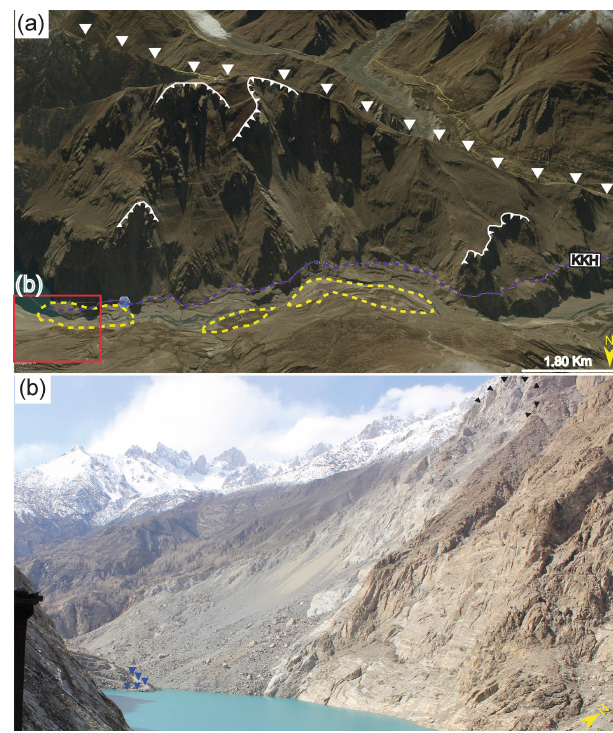
Figure 15. High landslide susceptibility along the highway in Hunza Valley (Google Earth, 2017c, Bing Maps) (for location see Box “Z” in Fig. 13b). (a) Overview of 11km long small section west of the Attabad Lake: white lines are representing the main scarps of old large landslides/rock avalanches which dammed the Hunza River in past; dotted yellow circles represent deposits of these old landslides; white arrows are showing location of local fault. (b) At- tabad landslide (in red box of panel a ); blue arrows are showing the highway submerged in lake